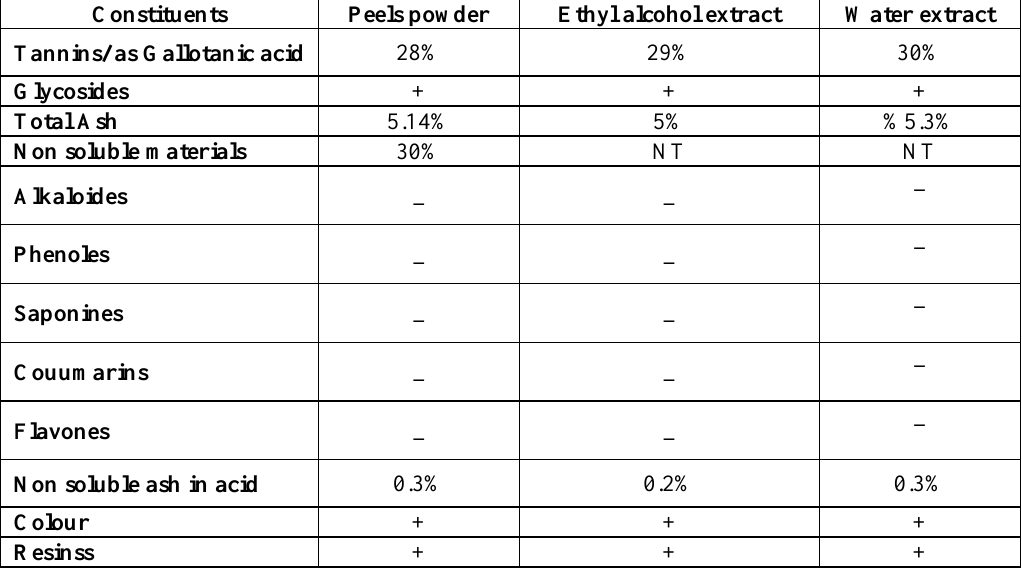
Table (7) - Active Ingredients of pomegranate Fruit Rinds